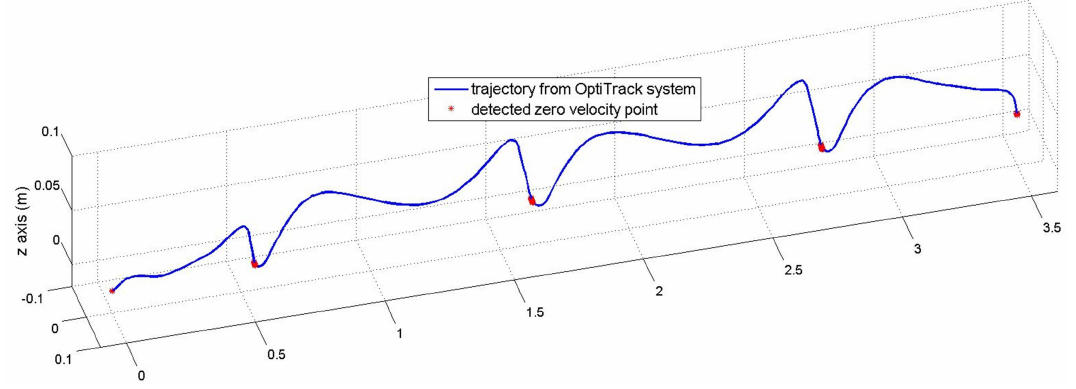
Figure 13. Trajectory of foot and detected zero velocity points.